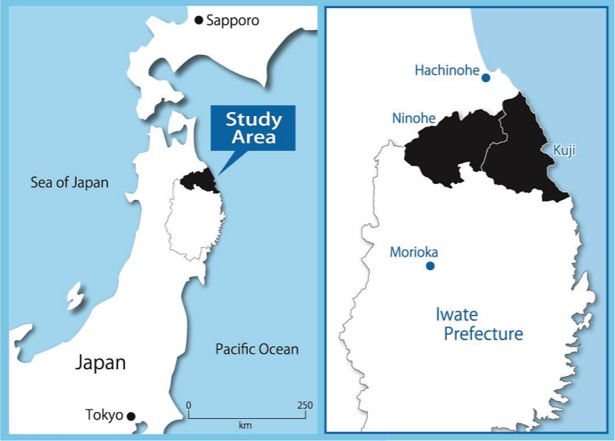
Map of the study area.The black zone indicates the study area, including Kuji and Ninohe in northern Iwate Prefecture, northeast of Honshu, Japan. The population was 131,341 in the study area at the baseline survey (2002).